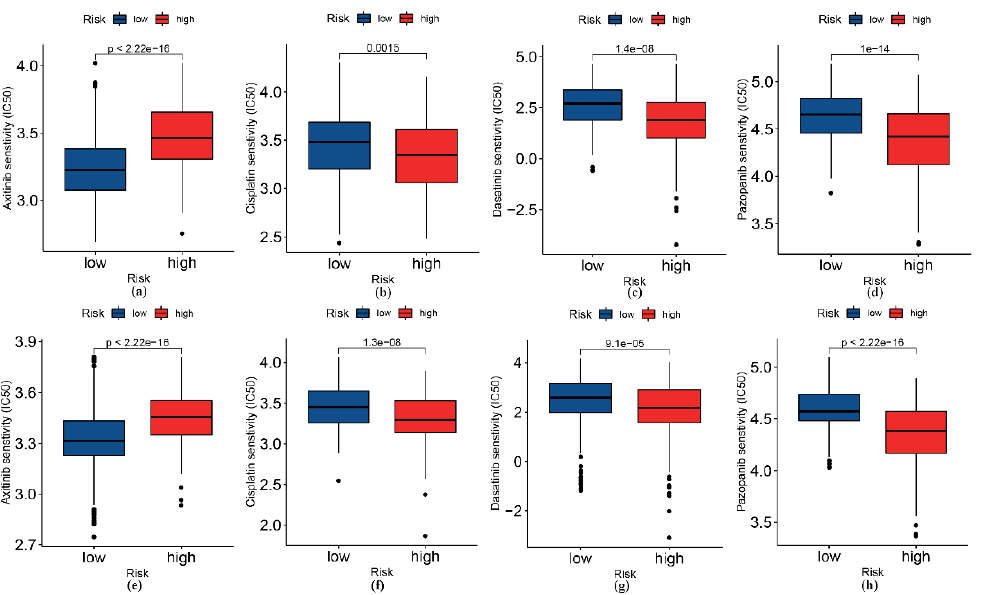
Figure 7. Sensitivity analysis between the high- and low-risk groups for four drugs: axitinib, cisplatin, dasatinib, and pazopanib. ( a – d ) TCGA cohort. ( e – h ) CGGA cohort.